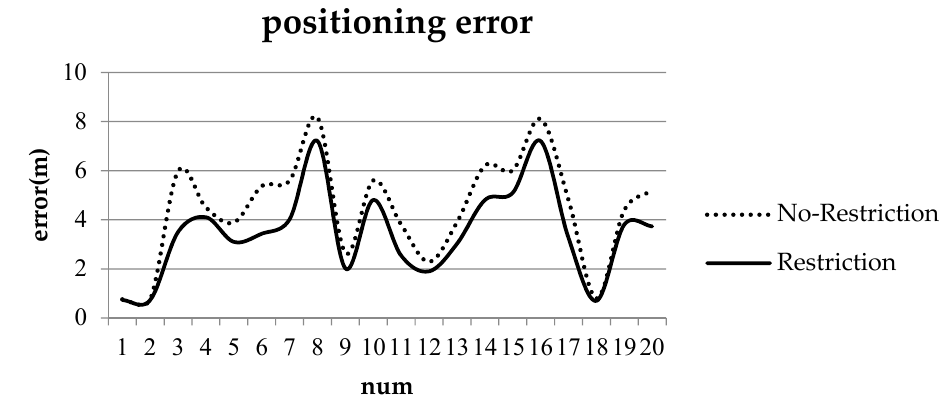
Figure 15. Positioning errors with two ROs: the dashed line indicates positioning errors with no restriction, and the solid line indicates positioning errors with restriction.